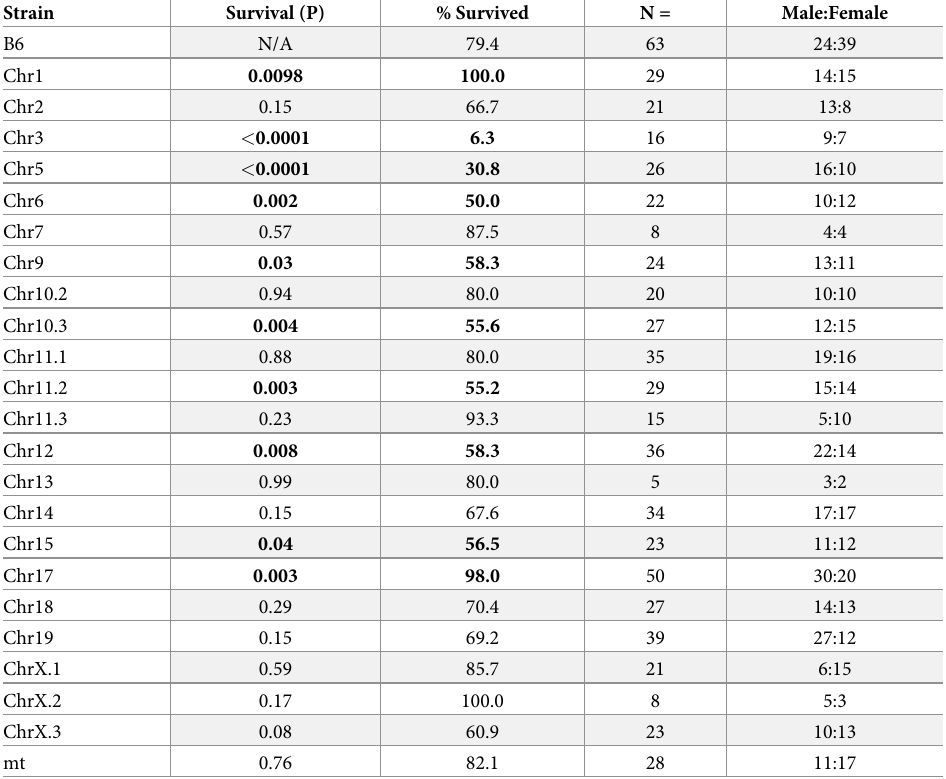
Table 1. Survival analysis of IAV-challenged consomic strains using pooled sex data. The indicated number (N) of each strain were challenged with IAV as described in Fig 3 . Male and female data were pooled. Significance of differ- ences in survival between B6 and each consomic strain were assessed using the Mantel-Cox test and the P value are reported, with P < 0.05 shown in bold font. Percent of mice surviving to the endpoint on day 20 is shown. Numbers of male and female mice studied are also shown. Data from for B6.Chr17 PWD represent pooled data from Chr17S and Chr17F strains. The low N for some strains (Chr13, Chr7, etc.) was a result of low availability of animals due to poor breeding